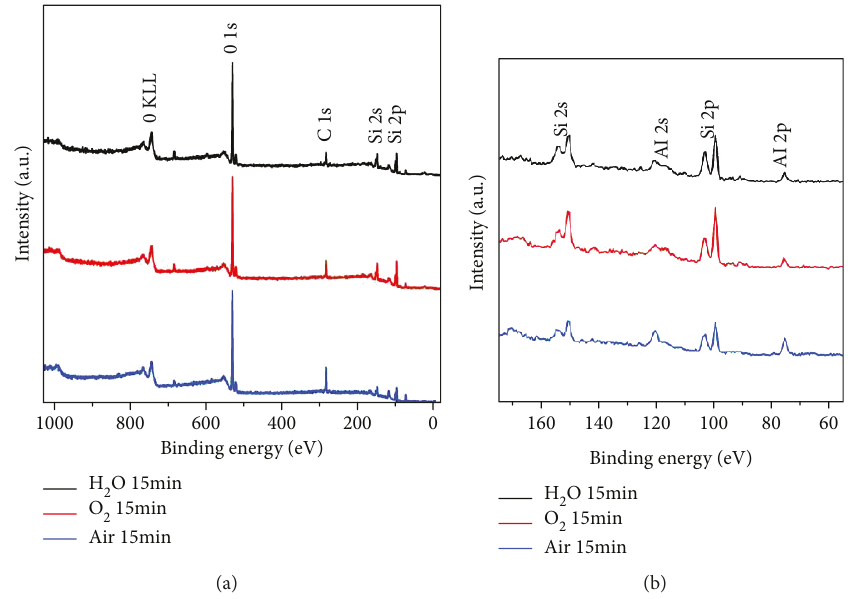
Figure 1: XPS spectra of Al-acac-based AlO expansion spectrum